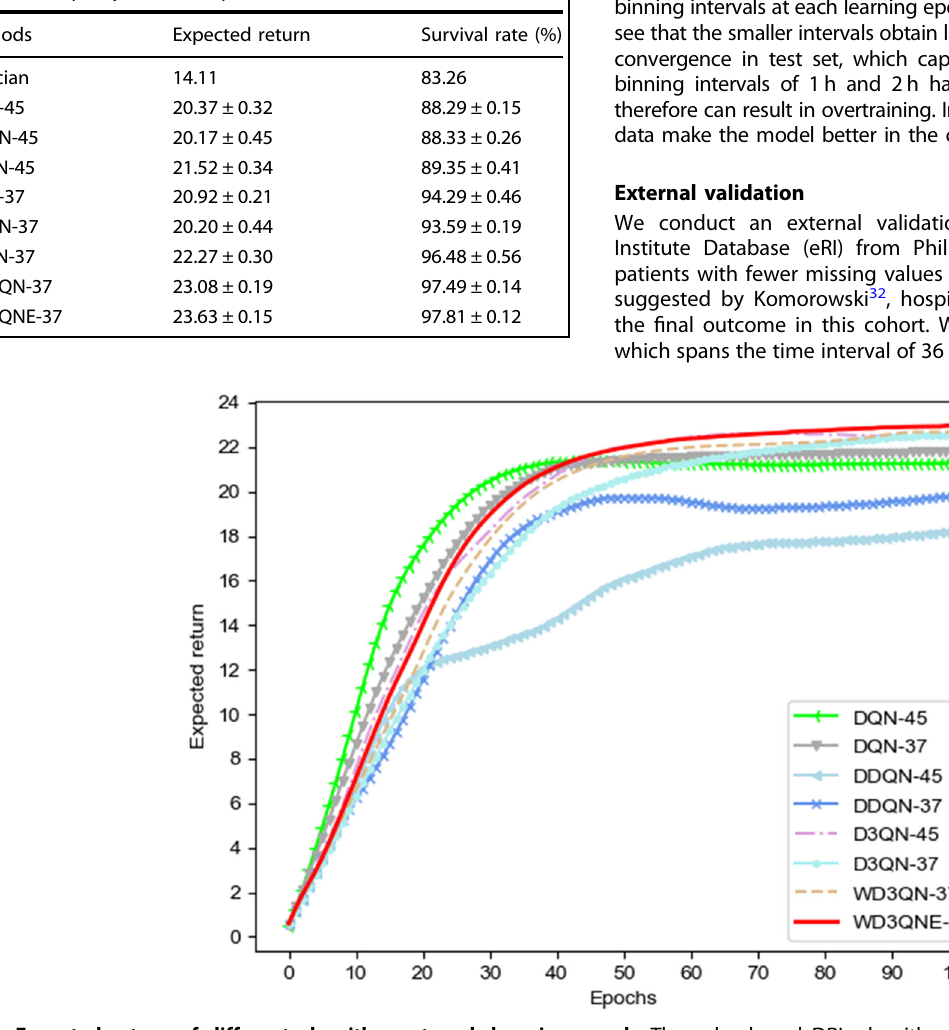
Fig. 2 Expected return of different algorithms at each learning epoch. The value-based DRL algorithms is run for 100 epochs in the validation set with feature selection (37 observation features) and without feature selection (45 observation features). Number 37 means 37 observation features that we select with the random forest algorithm. Number 45 means 45 observation features. Although the DQN algorithm converges fast in the beginning, it exhibits premature